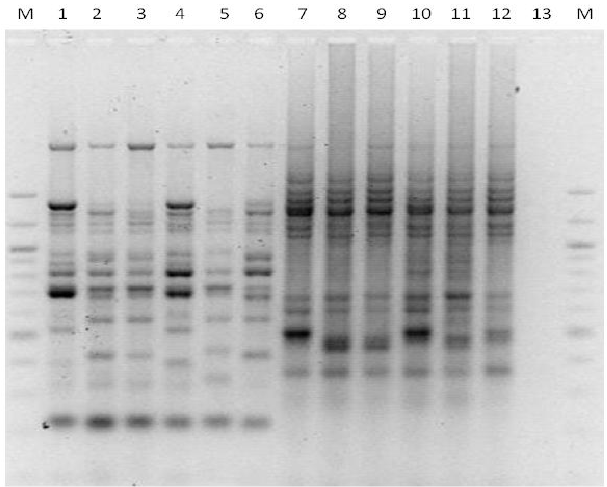
Figure 3. TRtRNA-PCR banding profiles generated with the primer pair sets ISSR-MB/TtRNASc (lanes 1–6) and 5CAG/TtRNASc (lanes 7–12). M: 100 bp DNA marker; 1, 7: L. thermotolerans CECT 10387; 2,8: L. thermotolerans Y-7; 3, 9: L. thermotolerans Lt P14; 4, 10: L. thermotolerans CECT 10387; 5, 11: L. thermotolerans Lt N2; 6, 12: L. thermotolerans Lt P9.